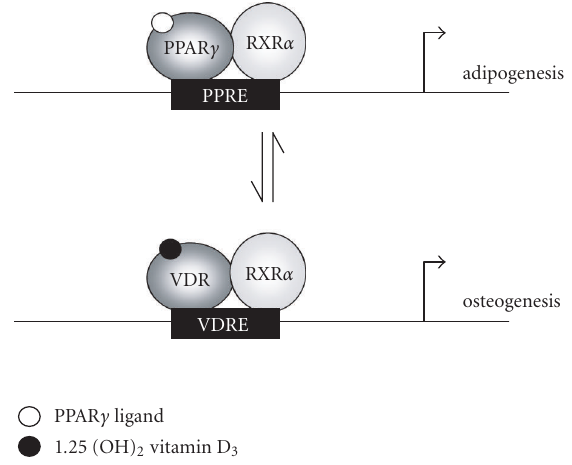
Figure 1: PPAR γ and vitamin D receptor interactions with RXR α may function as a switch between adipogenesis and